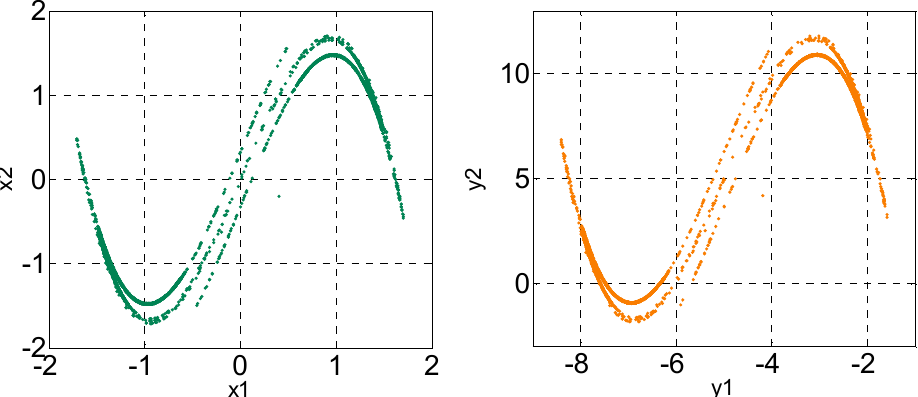
Figure 3. The strange attractors of the original and modulated Duffing map chaotic systems, respectively (left is before modulation, right is after modulation).